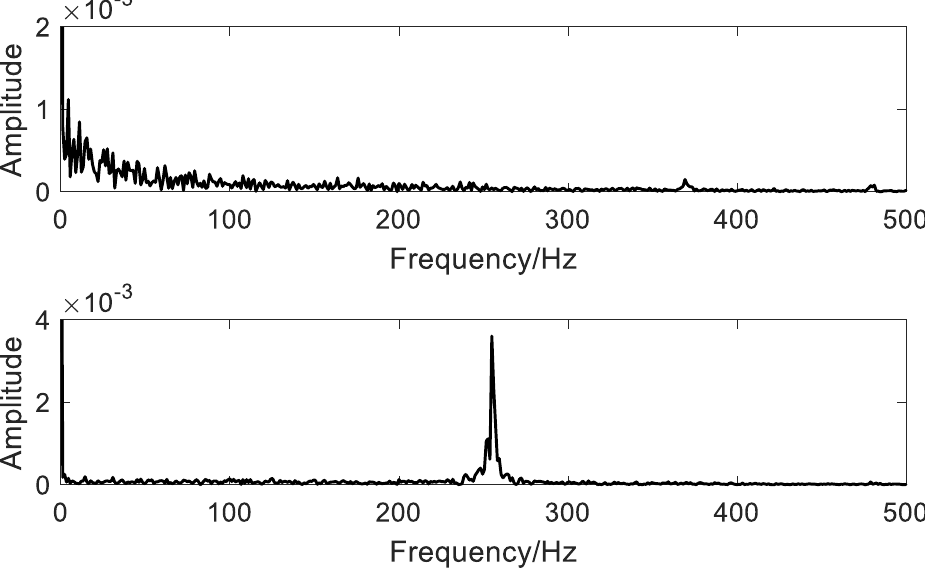
Figure 14. Spectra analysis of fourth component under F1 and F2.